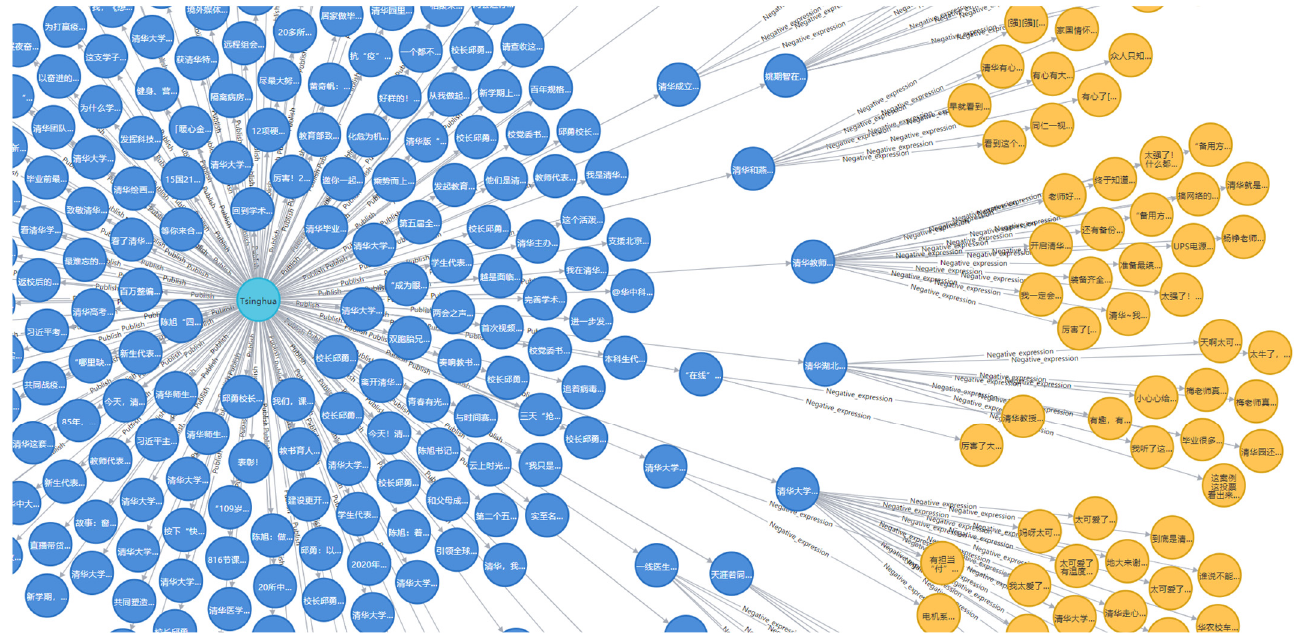
Figure 12. A Neo4j ‐ based Emotional Knowledge Graph of the Pandemic Theme of University Official Accounts.